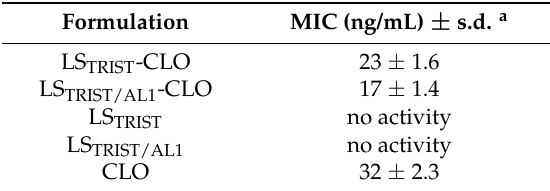
Figure 2. VPSME images of LS TRIST -CLO ( A ), LS TRIST/AL10 -CLO ( B ), and LS TRIST/AL1 -CLO ( C , D ). Bar represents 25, 50, 60, and 15 μ m in panels ( A – D ) respectively. LS acronyms are reported in Table 1.